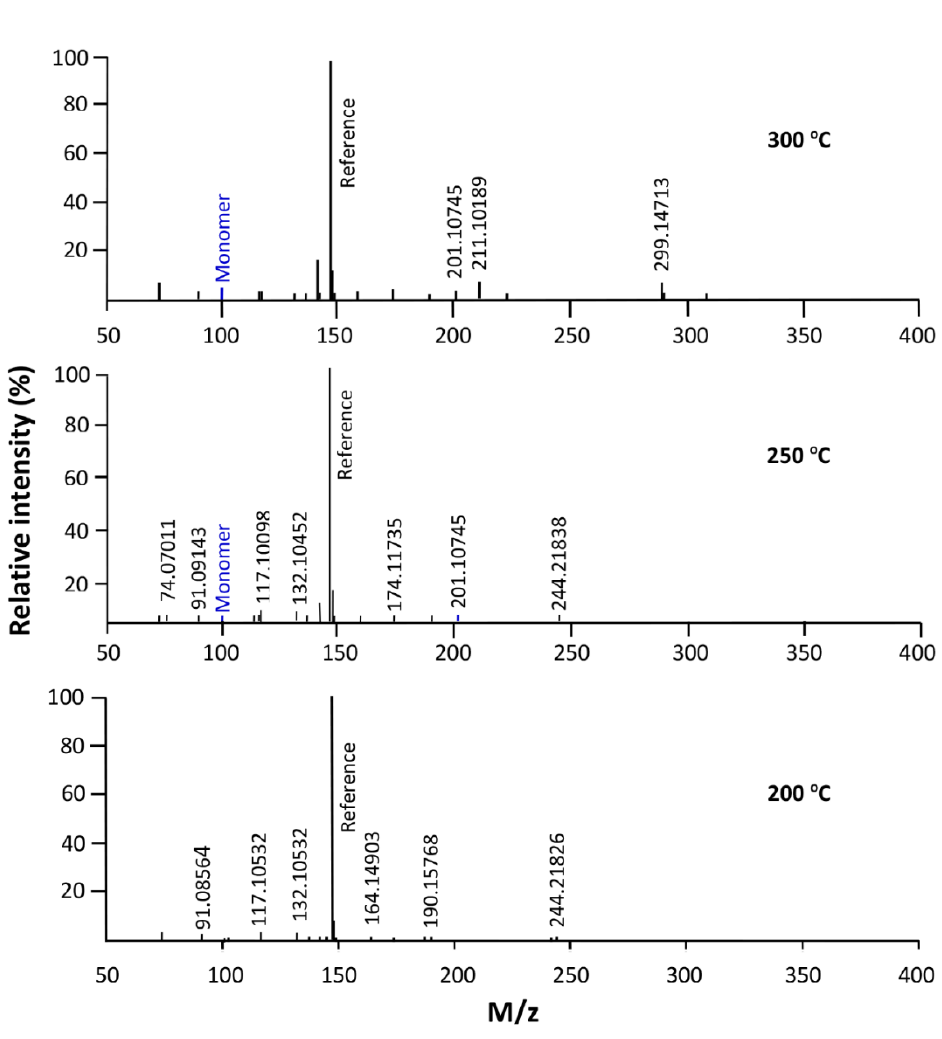
Figure 7. DART-Tof-MS spectrum of the isothermal decomposition of PMMA obtained in gas nitrogen at 200, 250 and 300 °C.